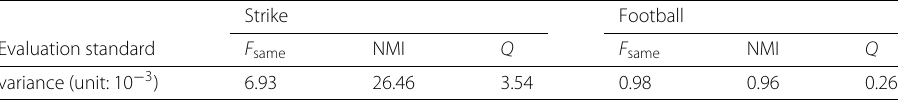
Table 3 Fluctuation variance of the proposed algorithm Strike Football Evaluation standard F same NMI Q